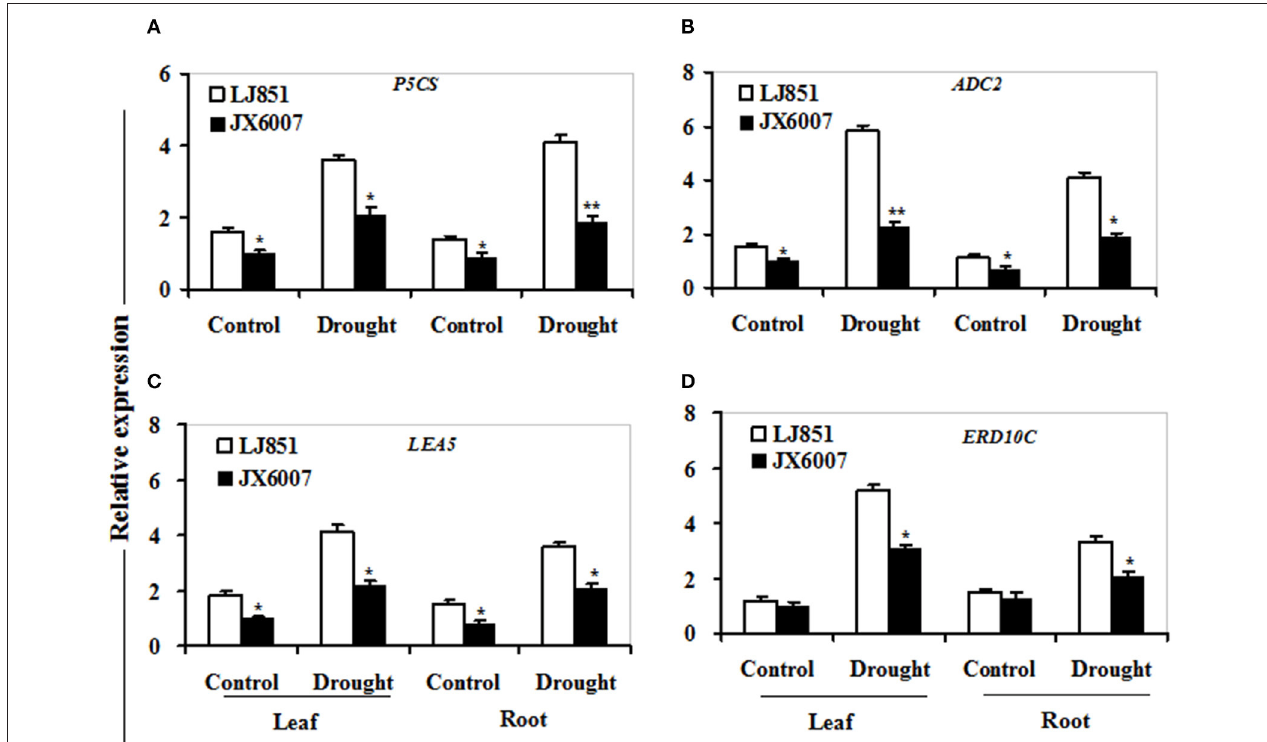
FIGURE 7 | Transcriptional expression of osmolyte biosynthesis and dehudrin-type genes in leaf and root under drought stress. RNA was extracted from 10-day stressed leaves and roots and reverse-transcribed to synthesize cDNA, which was used for qPCR analysis with primers specific for four genes P5CS (A) , ADC2 (B) , LEA5 (C) , and ERD10C (D) . Data represented means ± SE of three biological replicates. Bar indicates SE. ** t -test, with P < 0.01; * t -test, with P <